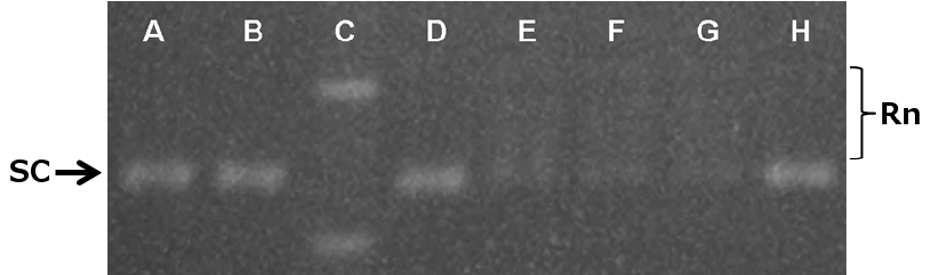
Figure 4. Effects of 16b and 17b on the inhibition of supercoiled DNA relaxation promoted by topoisomerase II. Supercoiled DNA (pRYG, 200 ng) was incubated with topoisomerase II (10 U) in the presence of the derivatives and then analyzed on an agarose gel without ethidium bromide. Lanes A and B, supercoiled DNA incubated with topoisomerase II and 100 µM of compounds 16b or 17b , respectively; lane C, ladder; lane D, supercoiled DNA without enzyme; lanes E,F,G, supercoiled DNA incubated with enzyme alone; lane H, supercoiled DNA with topoisomerase II in the presence of 100 μ M VP-16. The arrow indicates the supercoiled (SC) DNA band, and the brackets indicate the topoisomer bands (Rn).